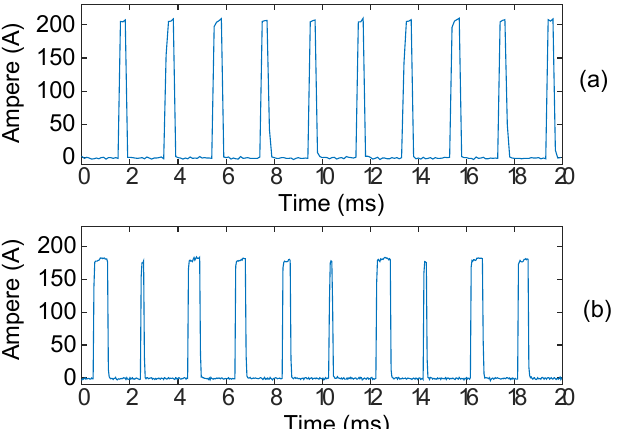
Figure 11. ( a ) Current in the load in the fixed PWM case. (b ) Current in the load in the constant DC